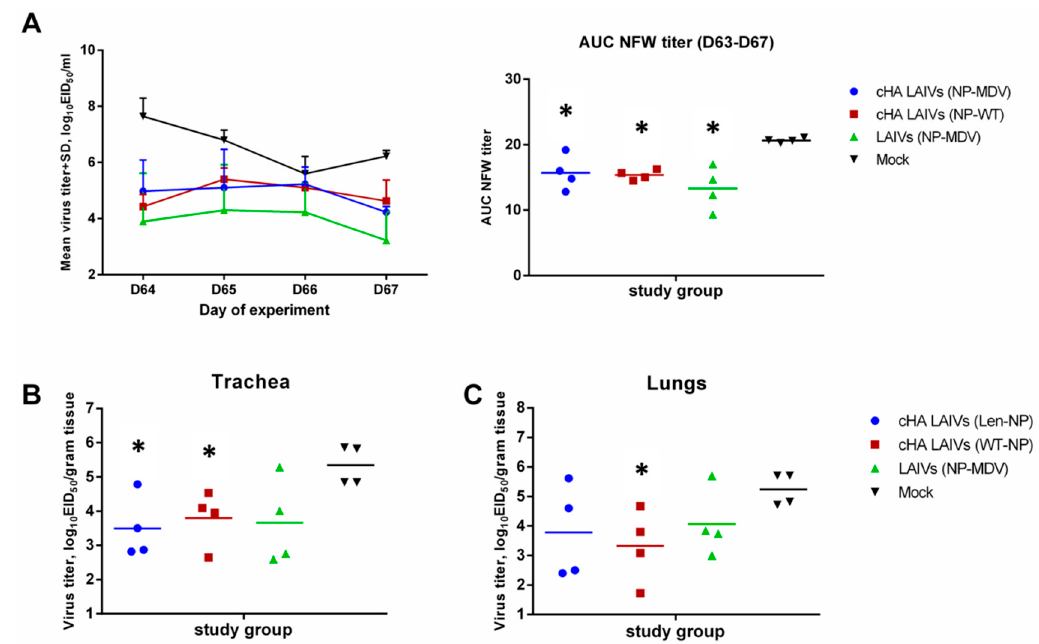
Figure 8. Replication of H1N1pdm09 challenge virus in respiratory tract of immunized ferrets. ( A ) Virus titers in nasal wash fluids at each time point during the challenge phase and the AUC of NFW viral titers for individual ferrets. ( B ) Viral titers in trachea. ( C ) Viral titers in lungs. * indicates significant difference with mock-vaccinated group (Mann-Whitney U test).